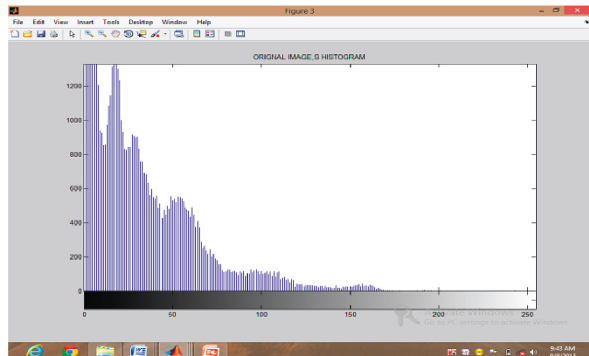
Figure 5: Histogram of original image of couple.